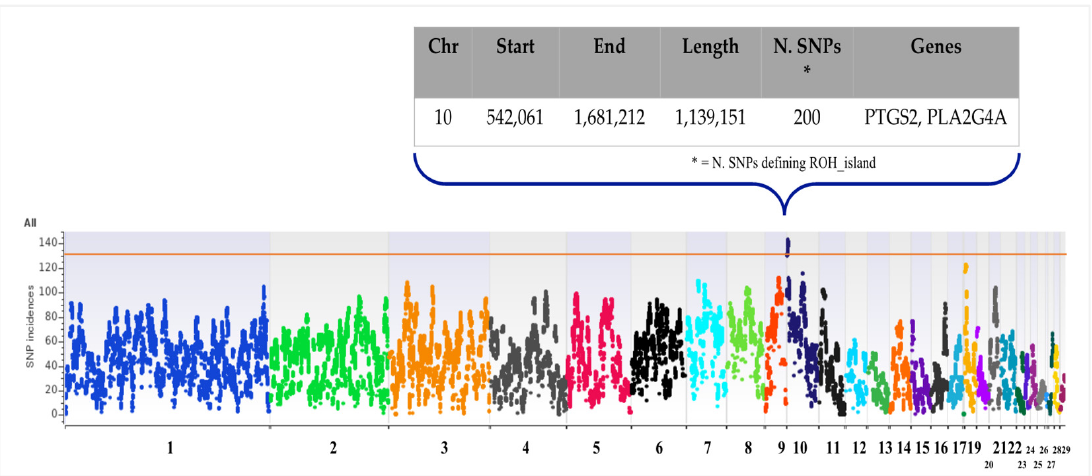
Figure 6. Manhattan plots of SNP incidences defining the ROH_island identified in overall birds, together with annotated gene and associated traits.